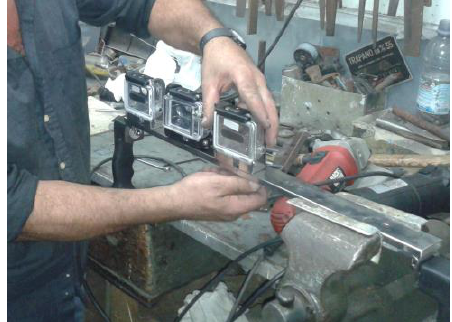
Figure 3. Phase of assembly